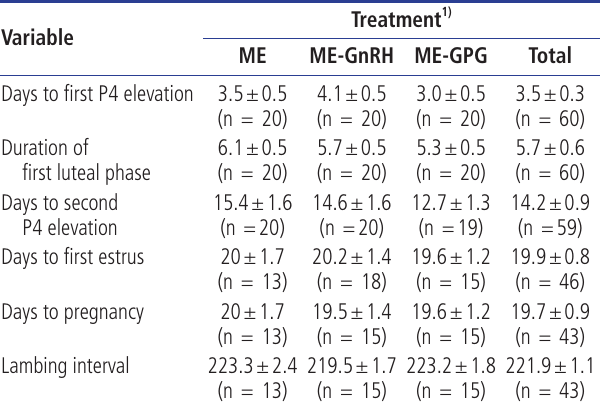
Table 5. Intervals to the first and second elevations of progesterone (P4), duration of the first luteal phase, intervals to estrus and to gestation, and lambing interval for the ewes of each group, irrespective of the type of initial response to treatments